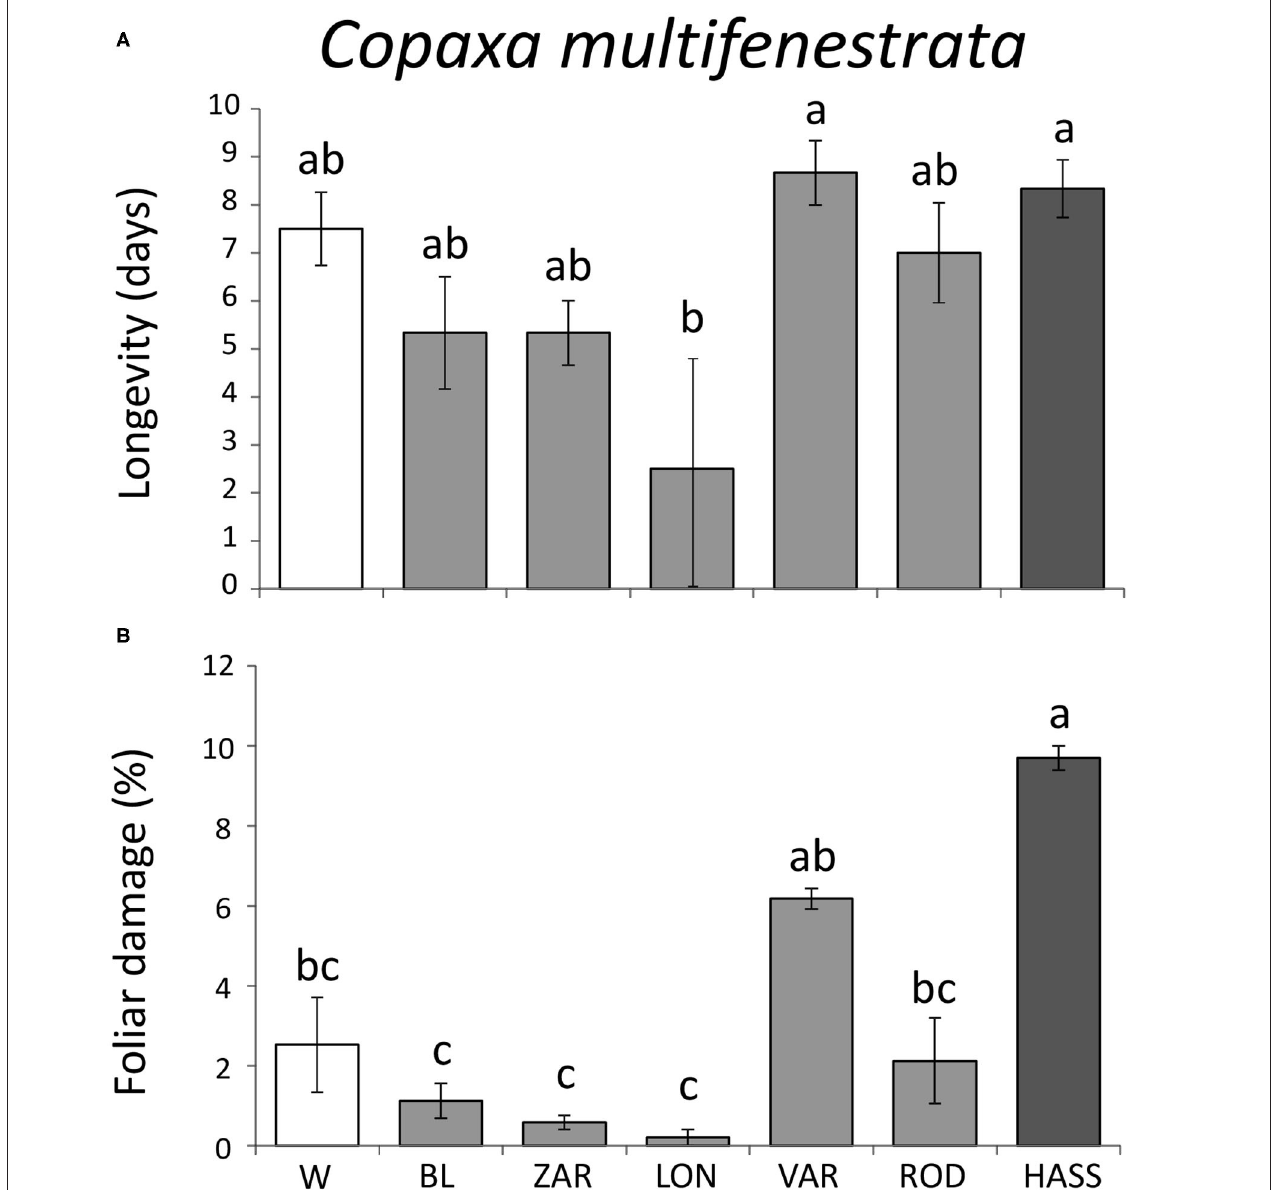
FIGURE 5 | Larval performance of the specialist avocado moth Copaxa multifenestrata on wild, landrace, and cultivated “Hass” avocado ( Persea americana ) genotypes: larval longevity (A) and percent foliar damage (B) . W = wild genotypes; landraces: BL = “Blanco,” LON = “Lonjas,” ZAR = “Zarcoli,” VAR = “Vargas,” and ROD = “Rodolfo.” Bars are means ± SE. Different letters indicate significant differences among genotypes ( P ≤ 0.05), according to Tukey’s HSD post-hoc